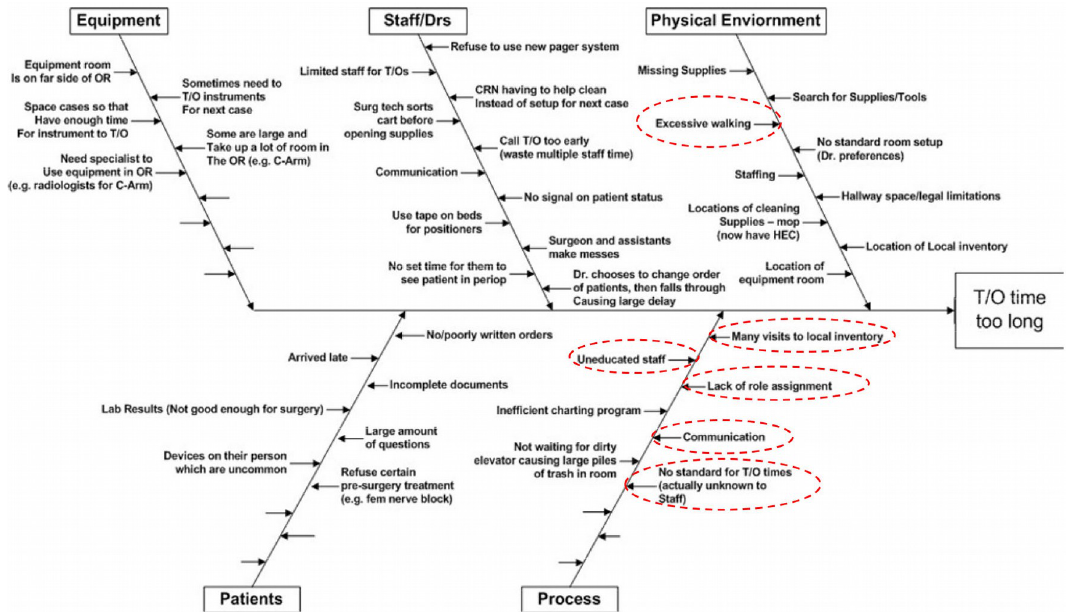
Figure 6. Fishbone diagram of the OR turnover